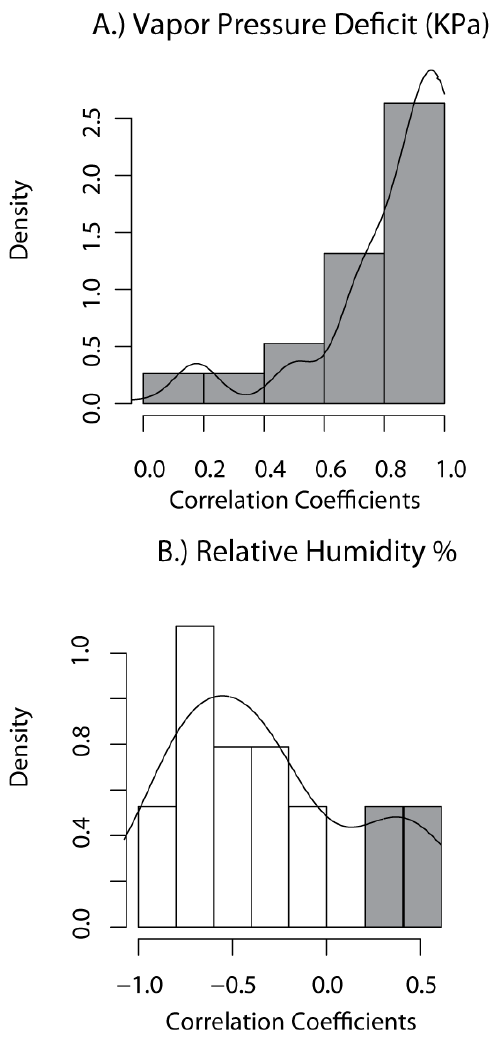
Figure 4. Density functions of Pearson correlation coefficients. Correlation coefficients are reported for relationships between δ s and vapor pressure deficit (A.) as well as relative humidity (B.). Probability density functions (black lines) are superimposed on histograms (boxes) where positive relationships are indicated by positive correlation coefficients (grey bars) and negative relationships are indicated by negative correlation coefficients (white bars). See Table 1 for actual correlation coefficients.